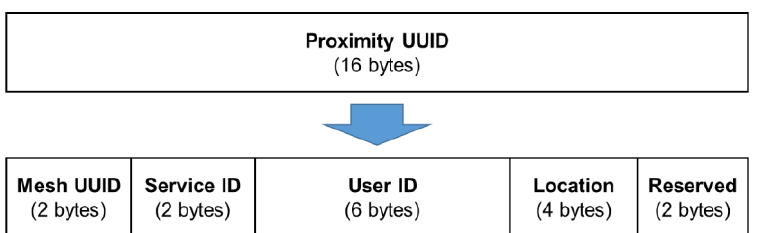
Figure 5. User’s presence state from the Mobile App is embedded in the Proximity universally unique identifier (UUID) field of a standard iBeacon message.